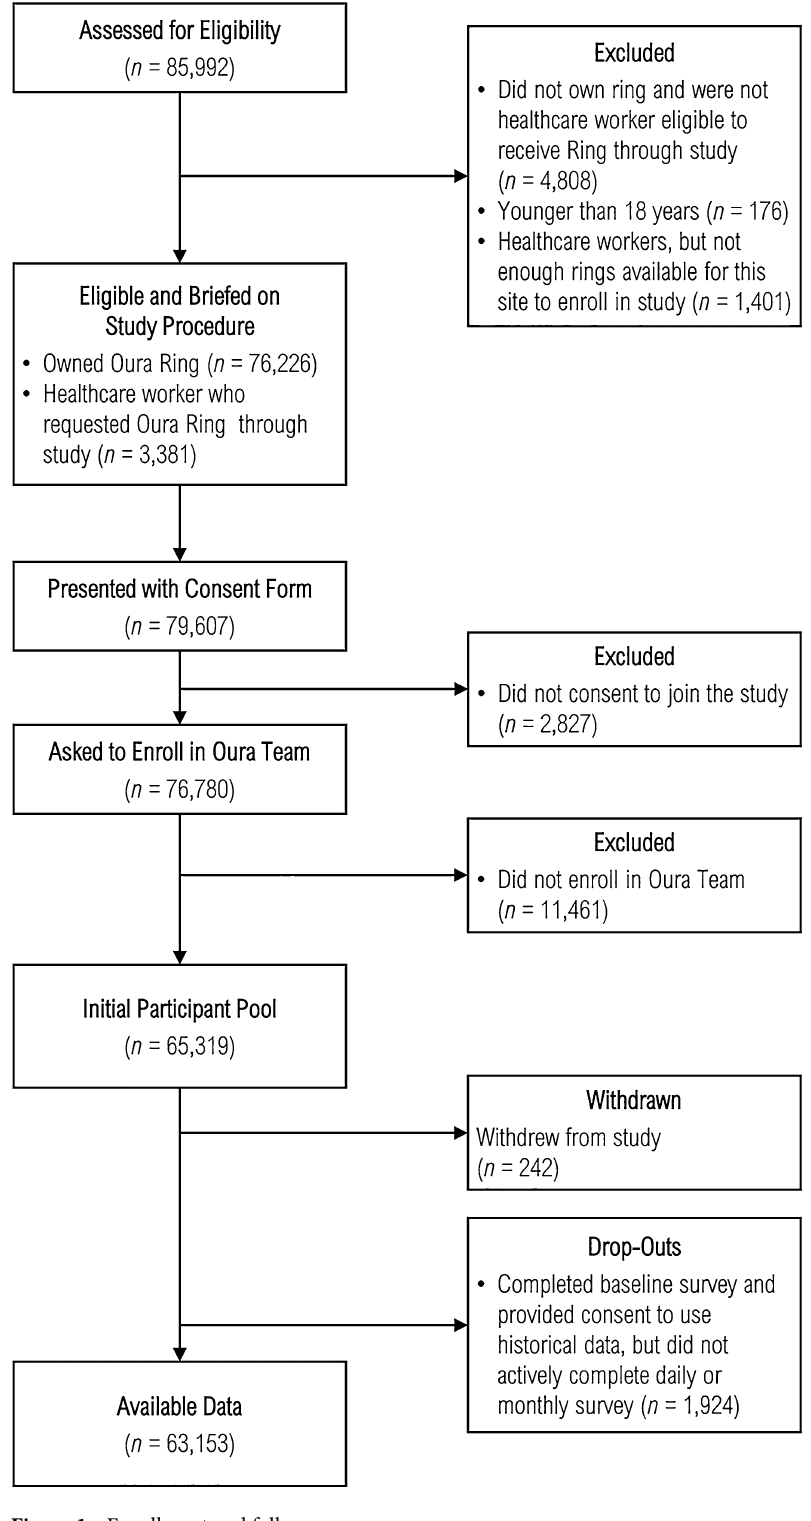
Figure 1. Enrollment and